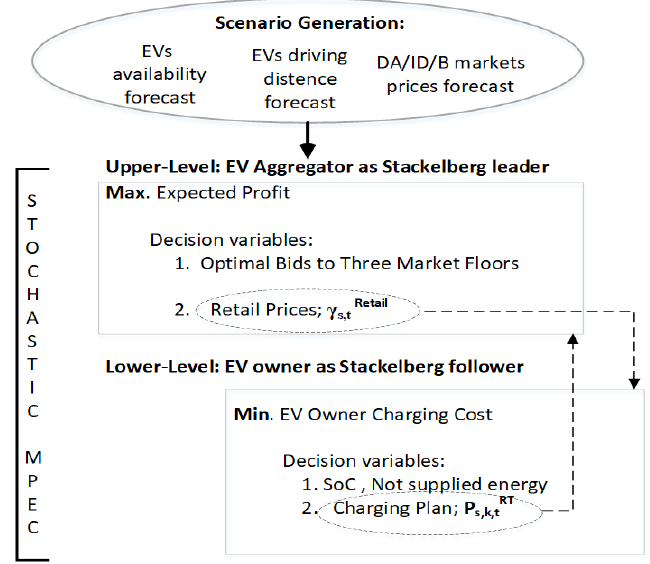
Figure 2. EV aggregator’s decision making procedure based on Stackelberg